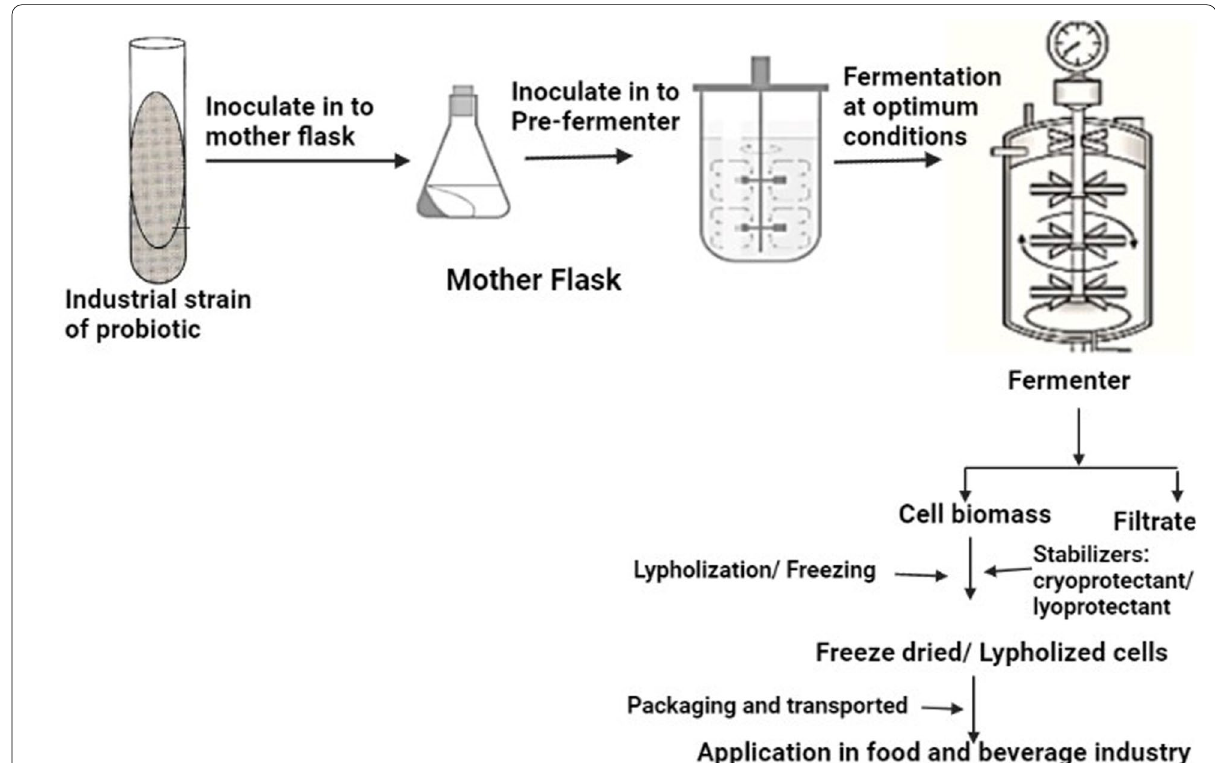
Fig. 1 Flow chart for the production of